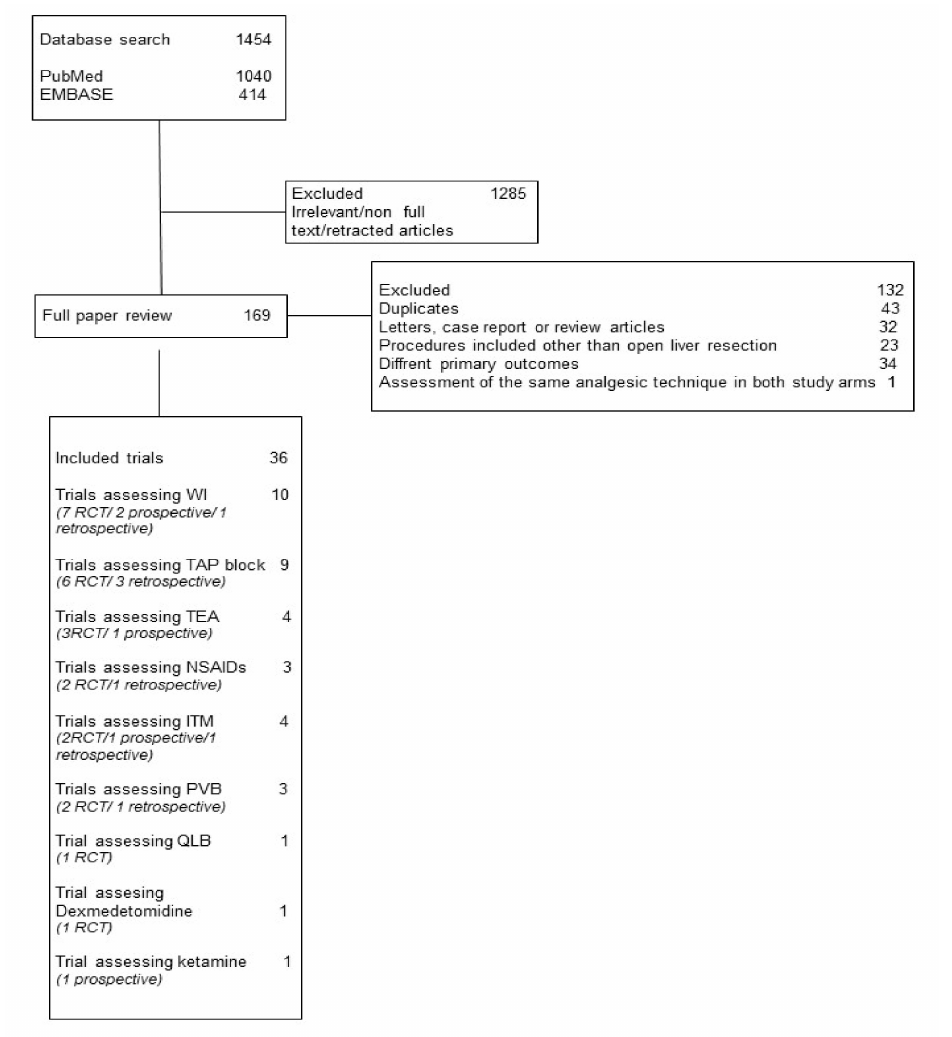
Figure 1. WI, wound infiltration; TAP, transversus abdominis plane; TEA, thoracic epidural analgesia; NSAIDs, nonsteroidal anti-inflammatory drugs ITM, intrathecal morphine; PVB, paravertebral block; QLB, quadratus lumborum